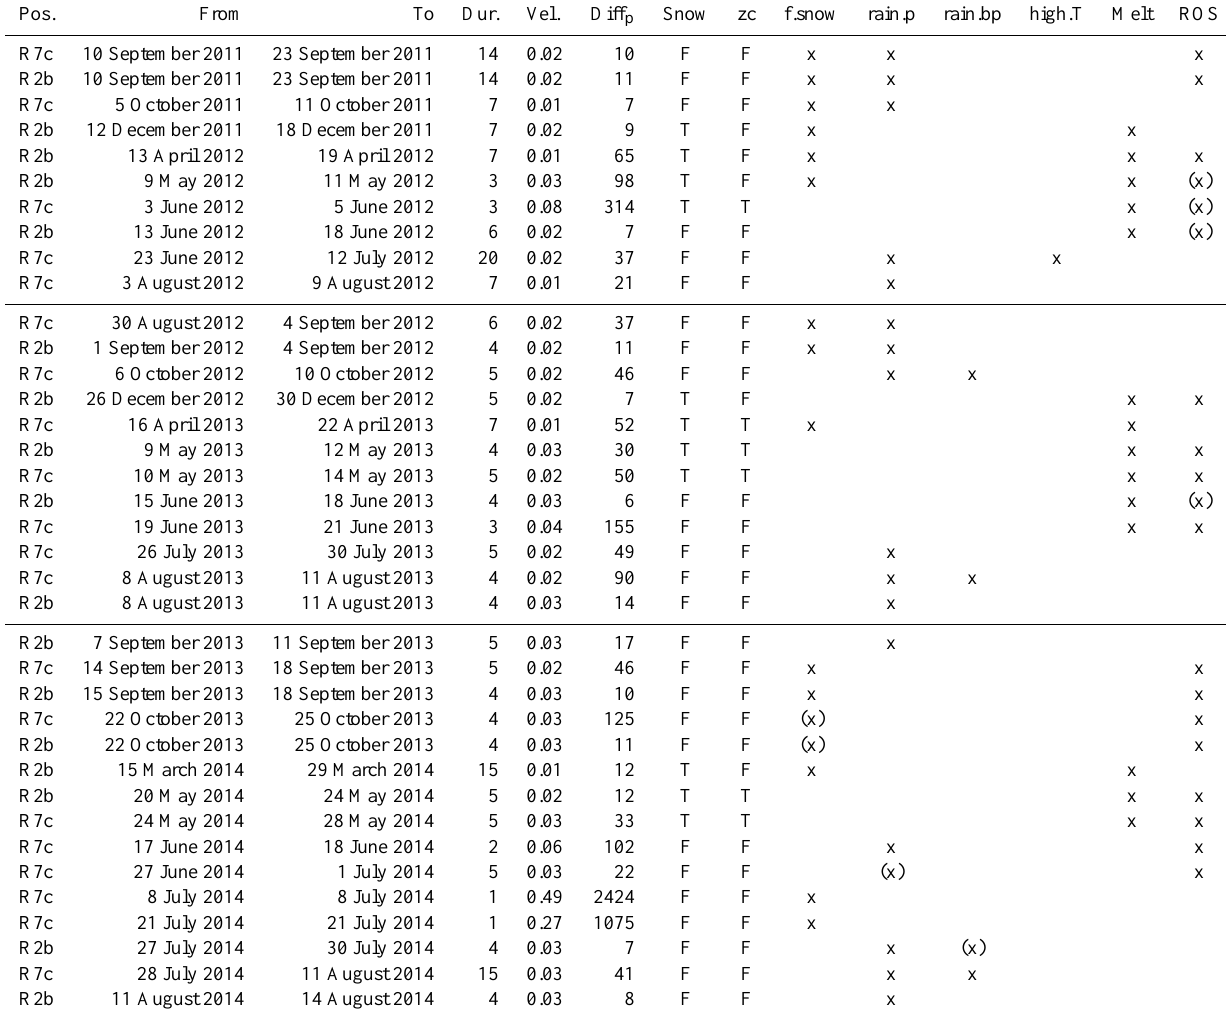
Table 7. Detected peaks. Main characteristics, including duration of peak (Dur.), the velocity (Vel.), diff p , during the period of winter snow cover (snow) and during zero curtain (zc) are given. In addition, supposed main triggers are given: f.snow – fresh snow that melts again within a few days; rain.p – intense ( > 10mm) liquid precipitation during the peak-period; rain.bp – intense liquid precipitation before the peak (within ≤ 7 days before the start of the peak-period); high.T – high temperature in summer; melt – strong snowmelt in winter or spring; ROS – rain on snow event.